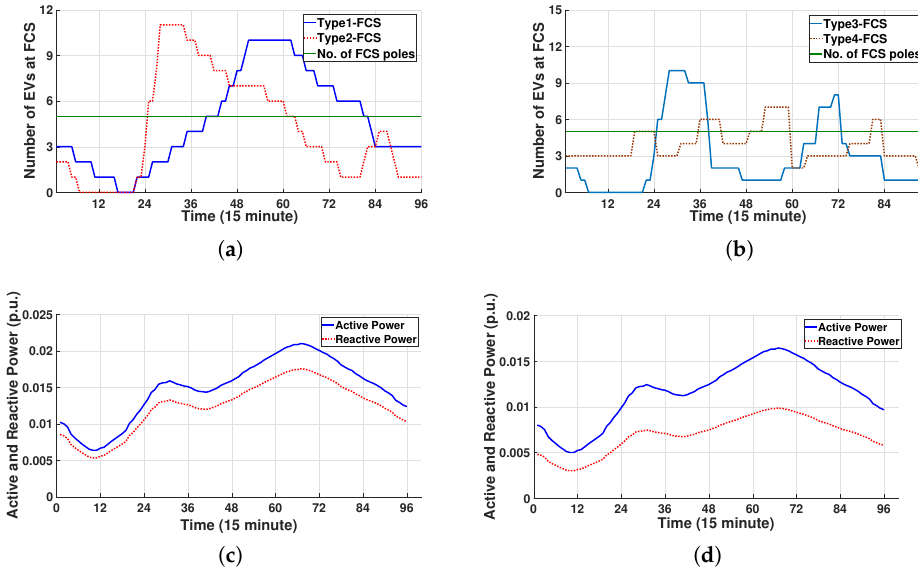
Figure 5. Profiles of operating conditions for transportation and power distribution systems prior to MCS dispatch. ( a ) Total number of EVs at Type1- and Type2-FCSs in 9-node transportation system. ( b ) Total number of EVs at Type3- and Type4-FCSs in 15-node transportation system. ( c ) Active and reactive power consumption in IEEE 13-bus power distribution system. ( d ) Active and reactive power consumption in IEEE 33-bus power distribution